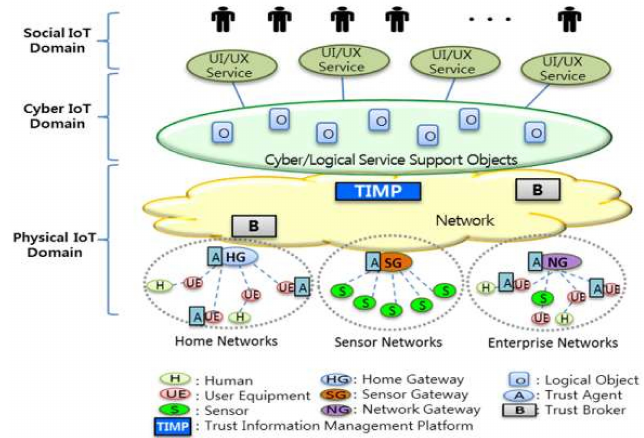
Figure 2. Trust in the physical, cyber, and social Internet of Things (IoT)